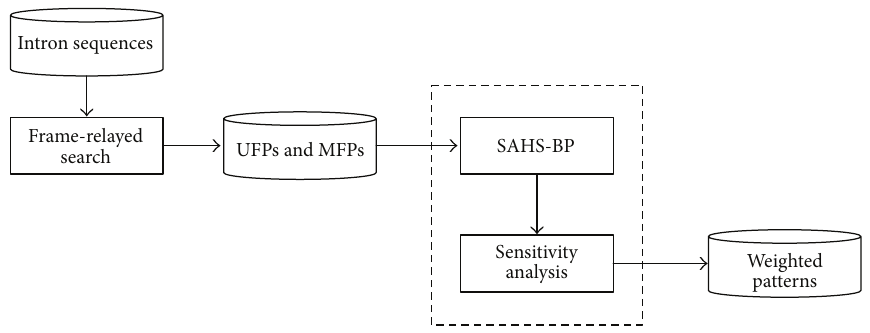
Figure 2: Procedure for discovering weighted patterns.